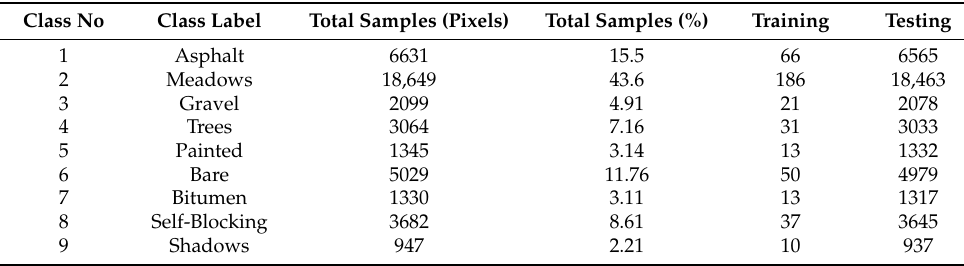
Table 2. Per Class information for the UP dataset.